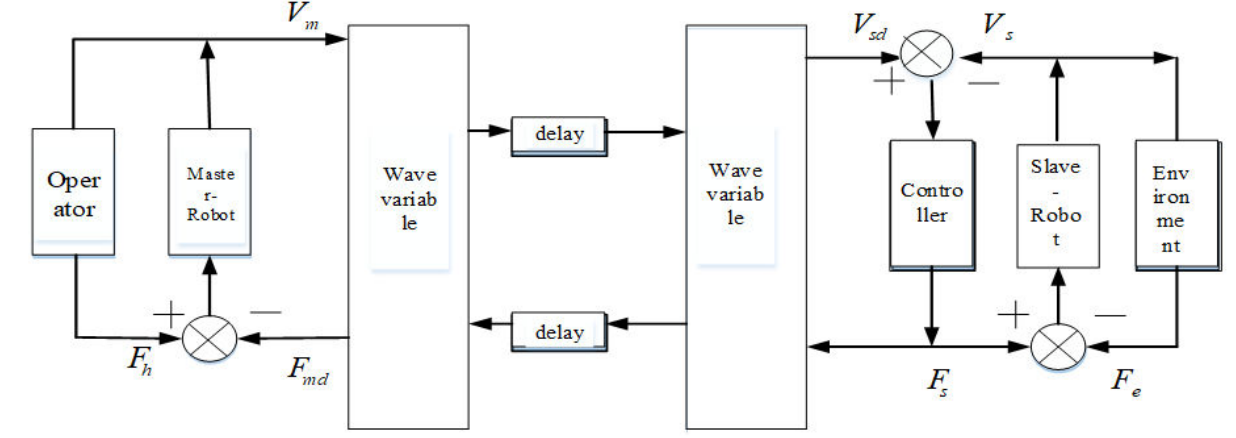
Figure 7. Control structure of a multi-DOF teleoperation system.